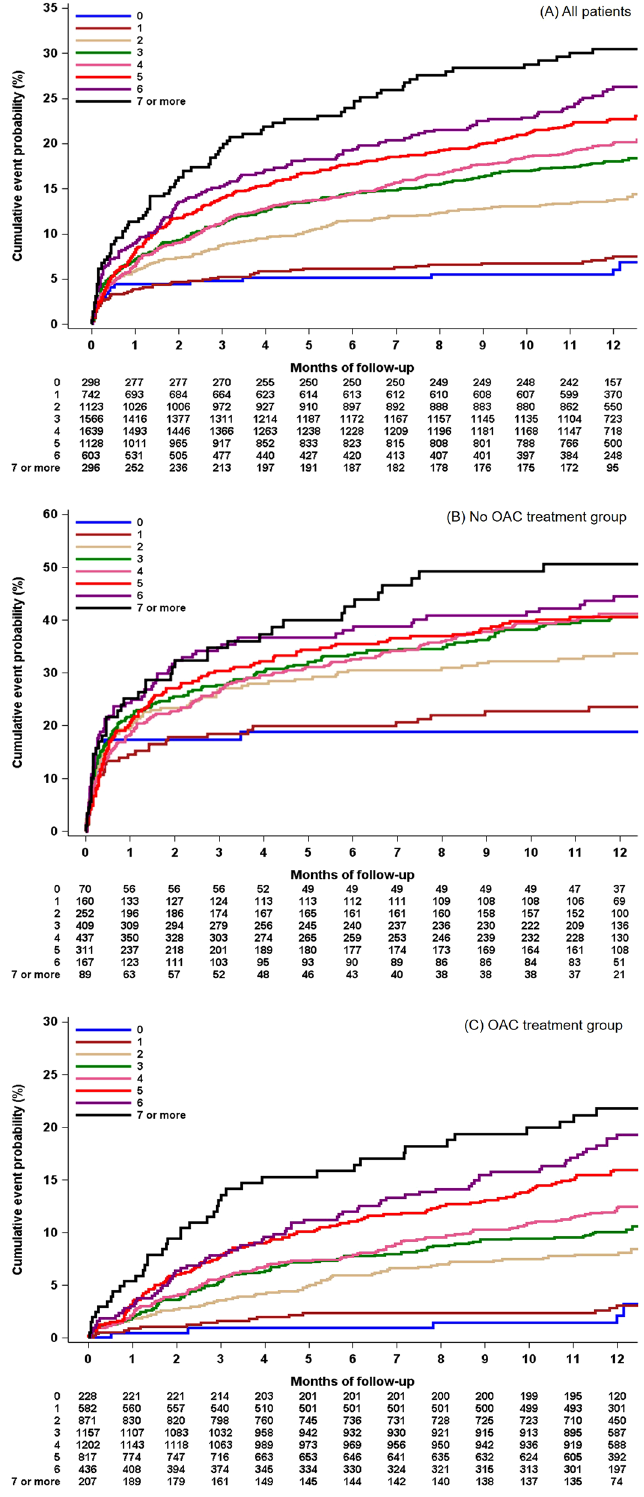
Figure 1. Kaplan–Meier curve of primary vascular outcome according to the individual CHA2DS2-VASc scores in the all-patient group ( A ), no OAC treatment group ( B ), and OAC treatment group ( C